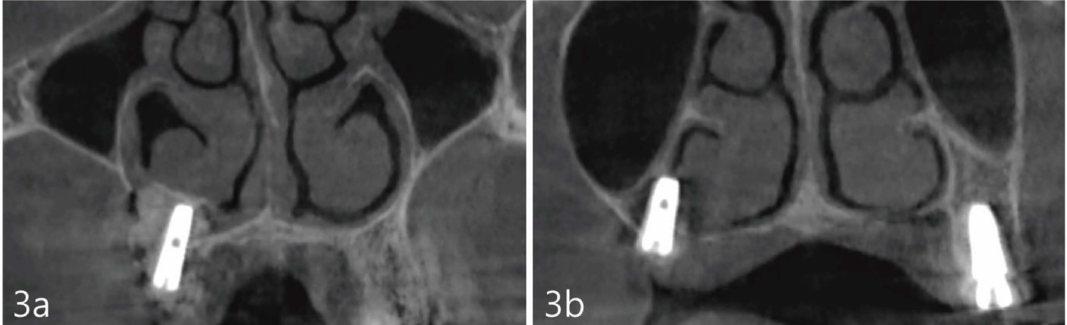
Figure 3. ( a ). Coronal views of the CBCT immediately after the implant placement showing adequate elevation and grafting with a well-defined periphery of the grafted site. ( b ). At site #2 tooth, the implant was placed with partial involvement of the lateral wall of the nasal